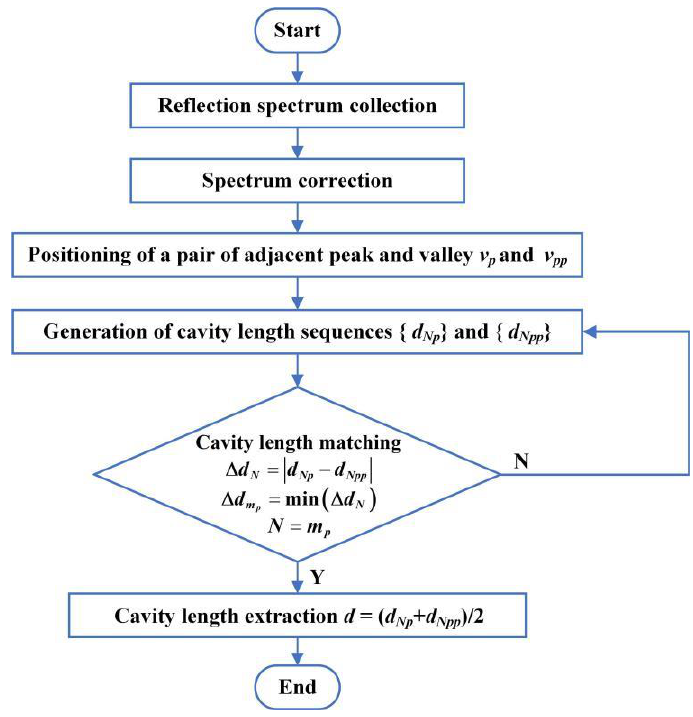
Figure 2. Flowchart of the CLSM algorithm.